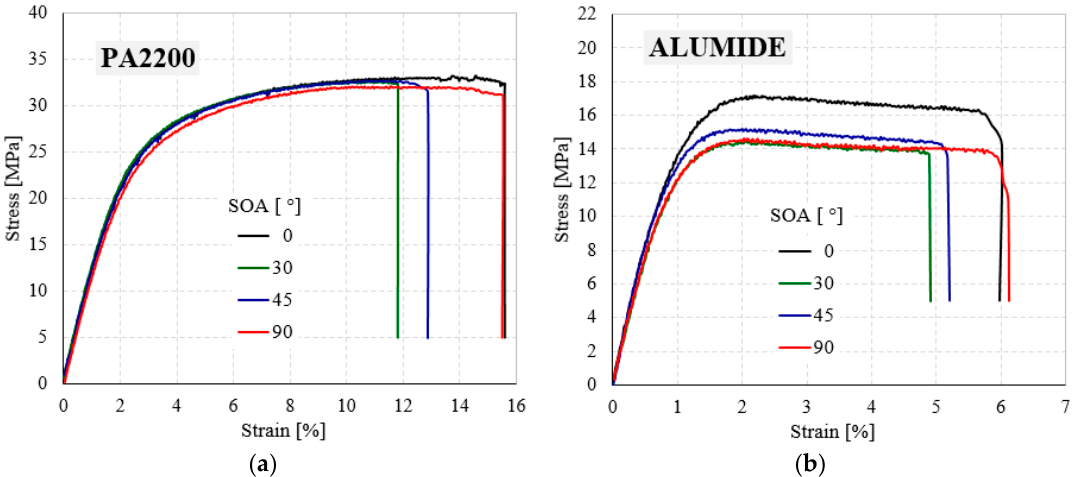
Figure 7. Typical tensile engineering stress - engineering strain curves of PA2200 ( a ) and Alumide ( b ) samples for different angle orientations (0°, 30°, 45°, and 90°).